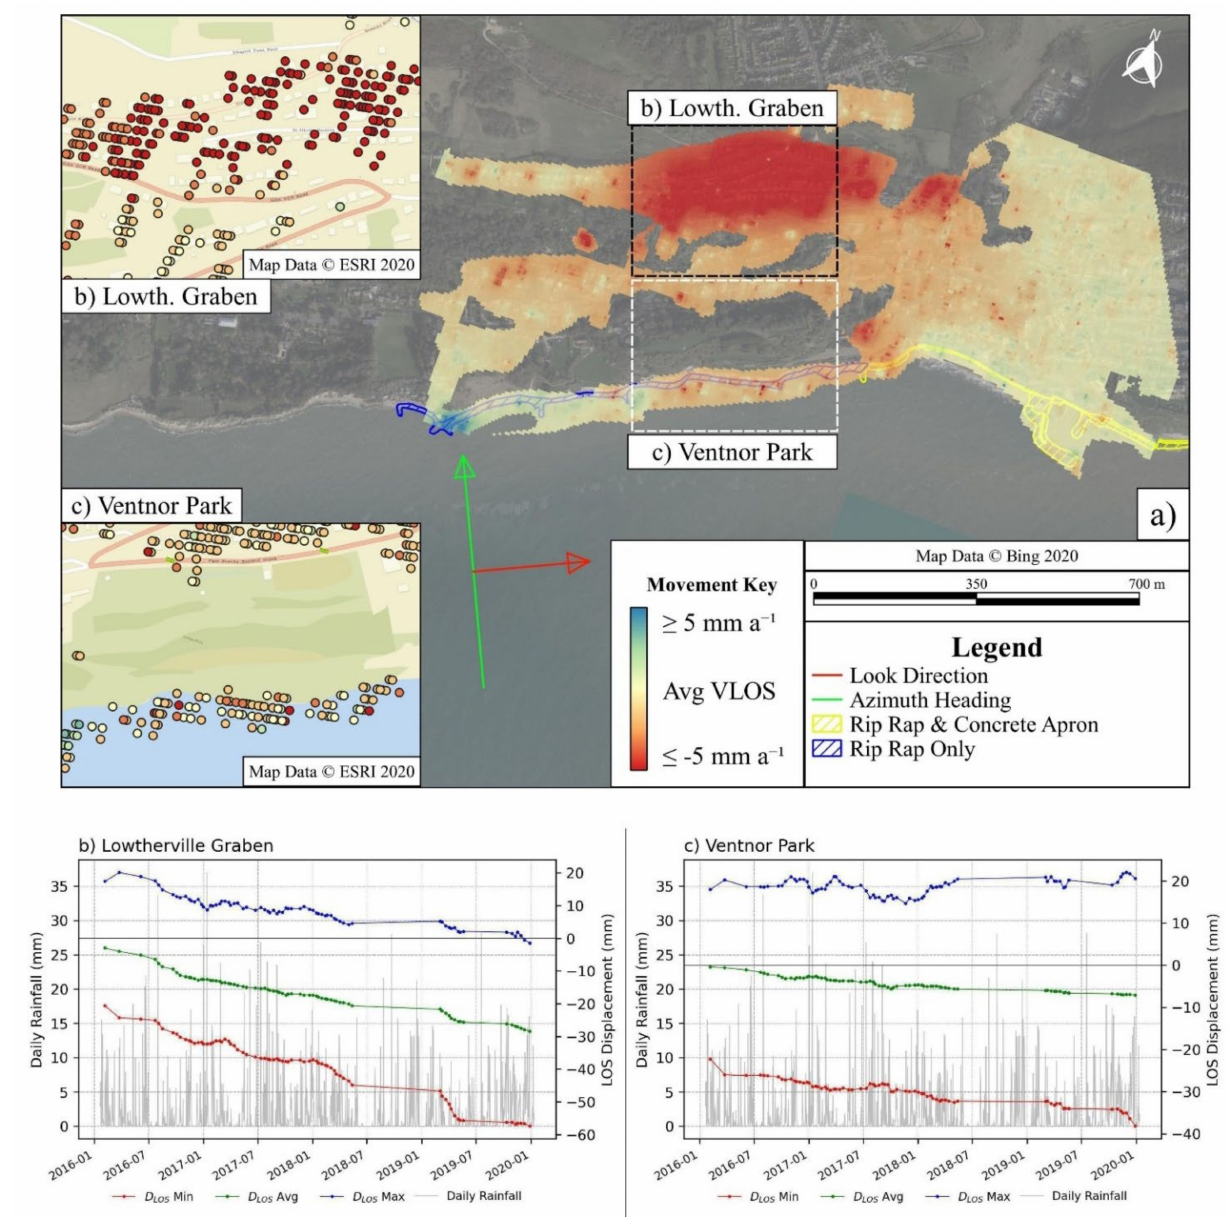
Figure 10. ( a – c ): Aerial view of the Ventnor landslide complex IDW of average velocity in mm a − 1 created from ascending data (Track 132) ( a ). Maximum, average and minimum seven scene moving average D LOS for all selected points shown as insets on ( a ), at the Lowtherville Graben ( b ) and Ventnor Park ( c ). Daily rainfall data from the Ventnor Park rain gauge are also plotted on ( b , c ). Image ( a ) was created on QGIS with background imagery from Bing Maps (2020), ( b , c ) using background imagery from the ESRI World Street Map (Service Layer Credits: Esri, DeLorme, HERE, USGS, Intermap, iPC, NRCAN, Esri Japan, METI, Esri China (Hong Kong), Esri (Thailand), MapmyIndia,